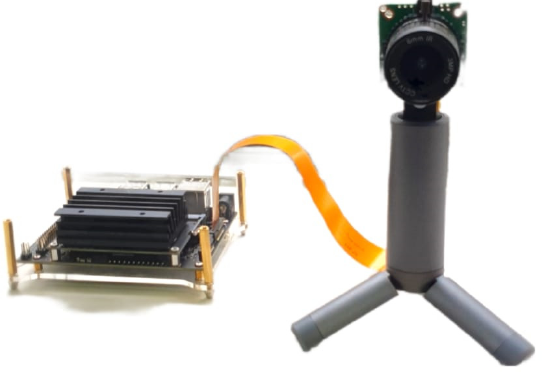
Figure 13. Hardware setup for system deployment using NVIDIA Jetson nano and a 12 MP camera.